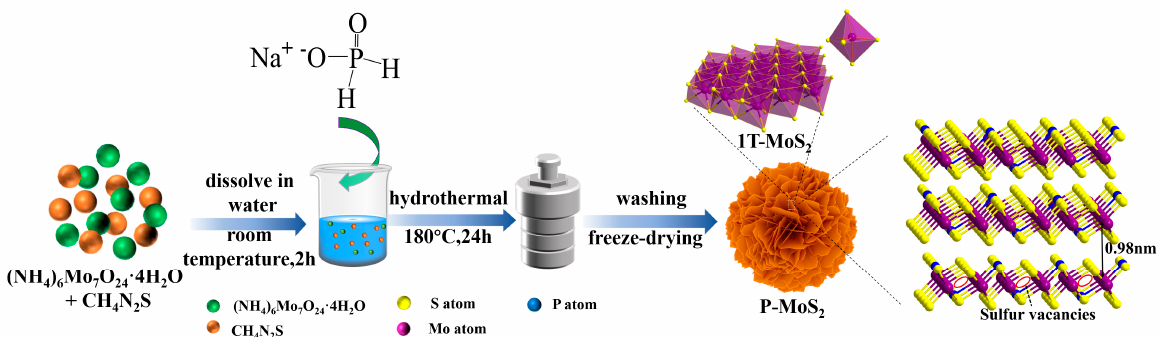
Figure 1. Schematic illustration of synthesis P-MoS 2 .